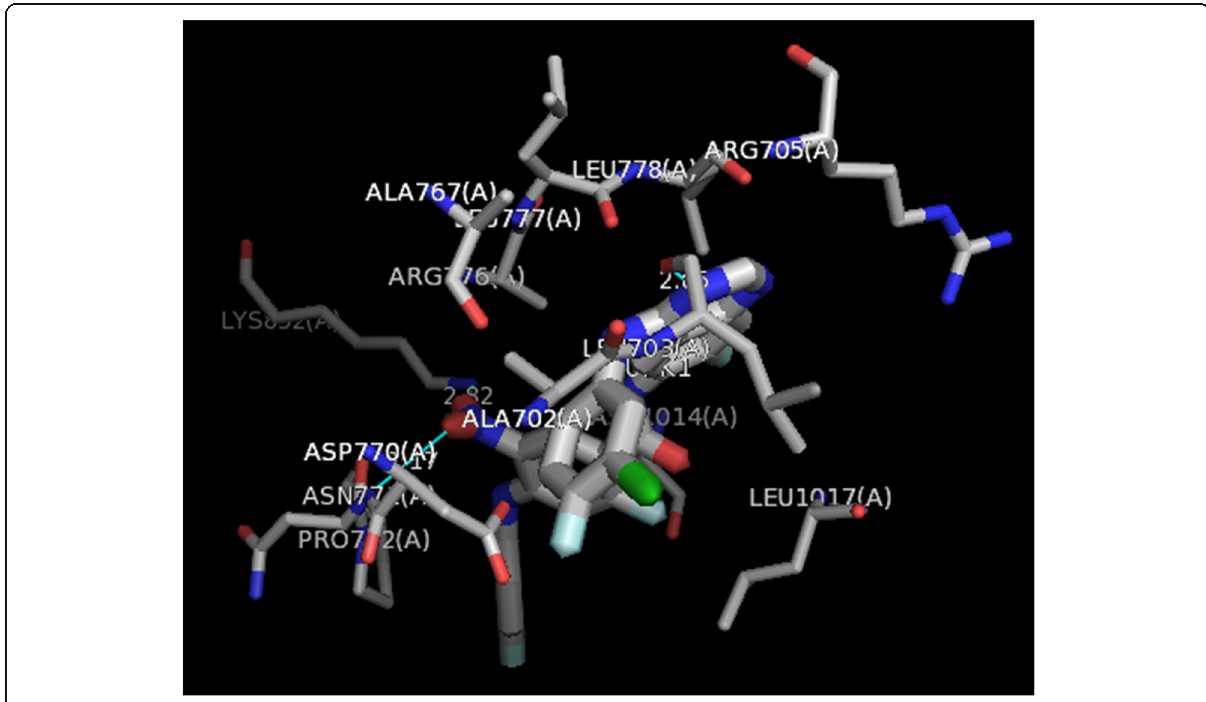
Fig. 6 Siteview 3D structure of the SDD3 receptor using